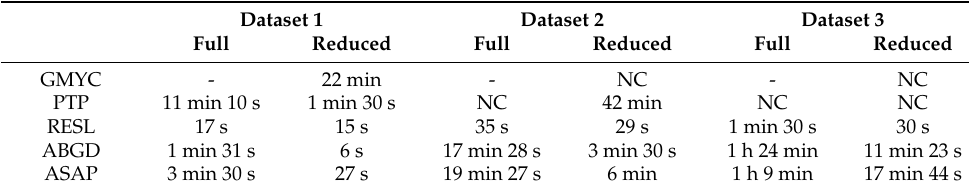
Table 2. Computing time required to analyse the three datasets with five delimitation methods. Each dataset was processed as full version or after reduction to a single sequence per haplotype. NC = non-convergent.